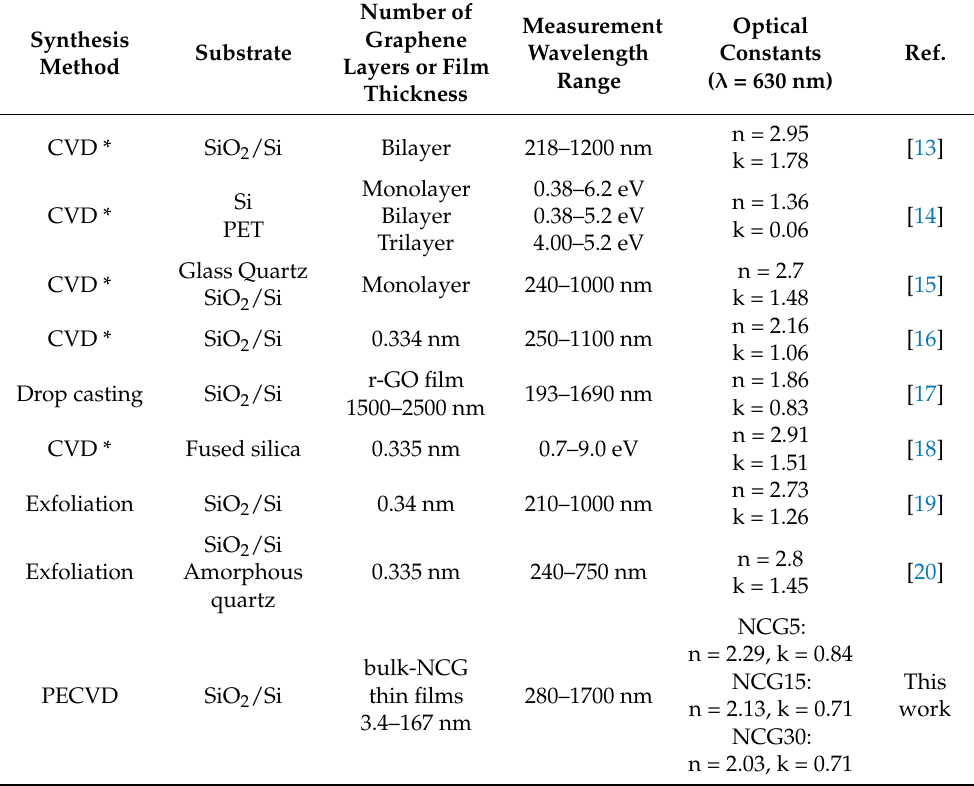
Table 1. Recent studies of graphene and graphene-derived materials’ optical constants, refractive index (n) and extinction coefficient (k), obtained by spectroscopic ellipsometry